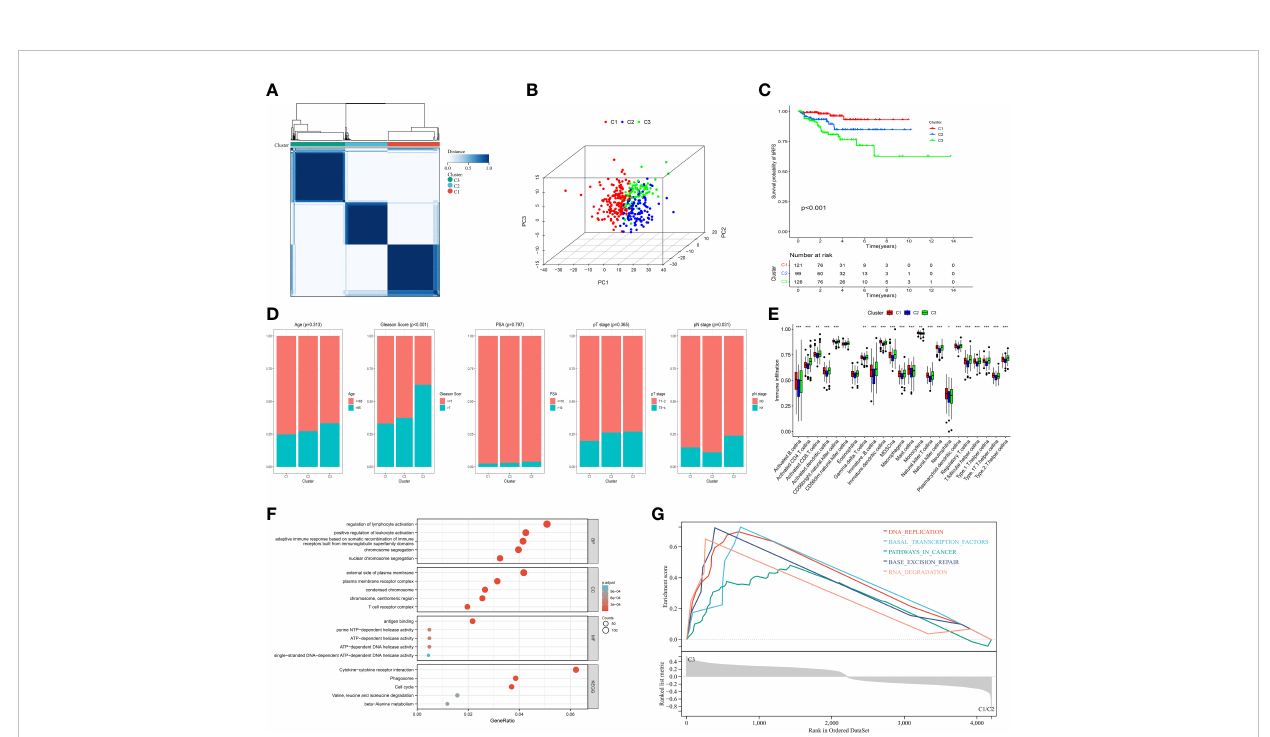
FIGURE 3 Identi fi cation of MRMGs clusters and phenotypic differences in PCa. (A) The consensus clustering of 307 MRMGs in three clusters (C1 = 121, C2 = 99, C3 = 126). (B) 3D-PCA plot displaying the distribution among three clusters. (C) Kaplan – Meier curves for the probability of bRFS grouped in three clusters. (D) Comparison of the clinicopathological features among three clusters. (E) Comparison of the immune in fi ltration among three clusters. (F) GO and KEGG analysis based on MRMGs-related DEGs among three clusters. (G) GSEA analysis based on MRMGs-related DEGs among three clusters. PCA, principal component analysis; bRFS, biochemical recurrence-free survival; GO, gene ontology (BP, biological processes; CC, cellular components; MF, molecular functions); KEGG, kyoto encyclopedia of genes and genomes; DEGs, differentially expressed genes; GSEA, gene set enrichment analysis. * P < 0.05, ** P < 0.01, *** P < 0.001.